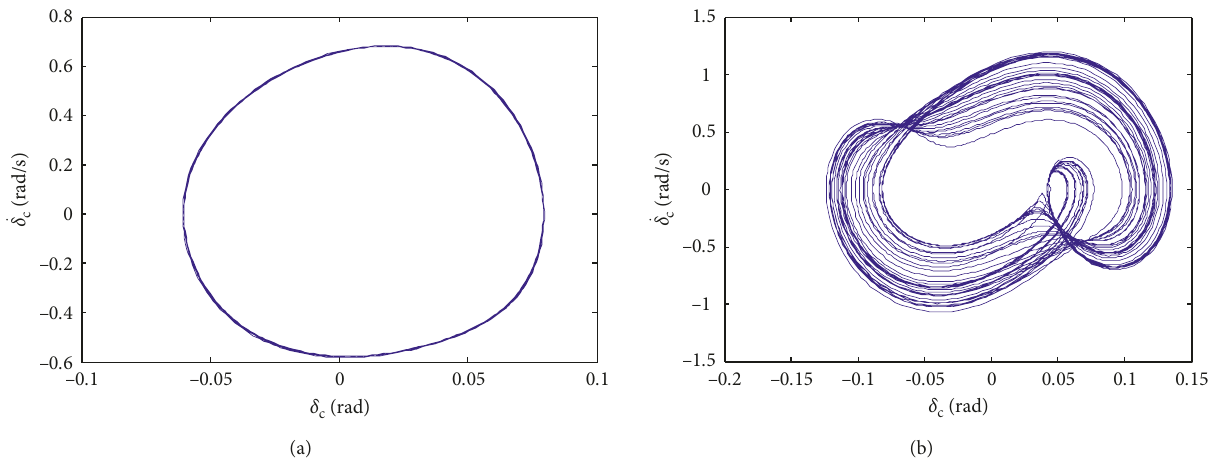
Figure 11: Phase diagrams of the compliance steering angle: (a) c